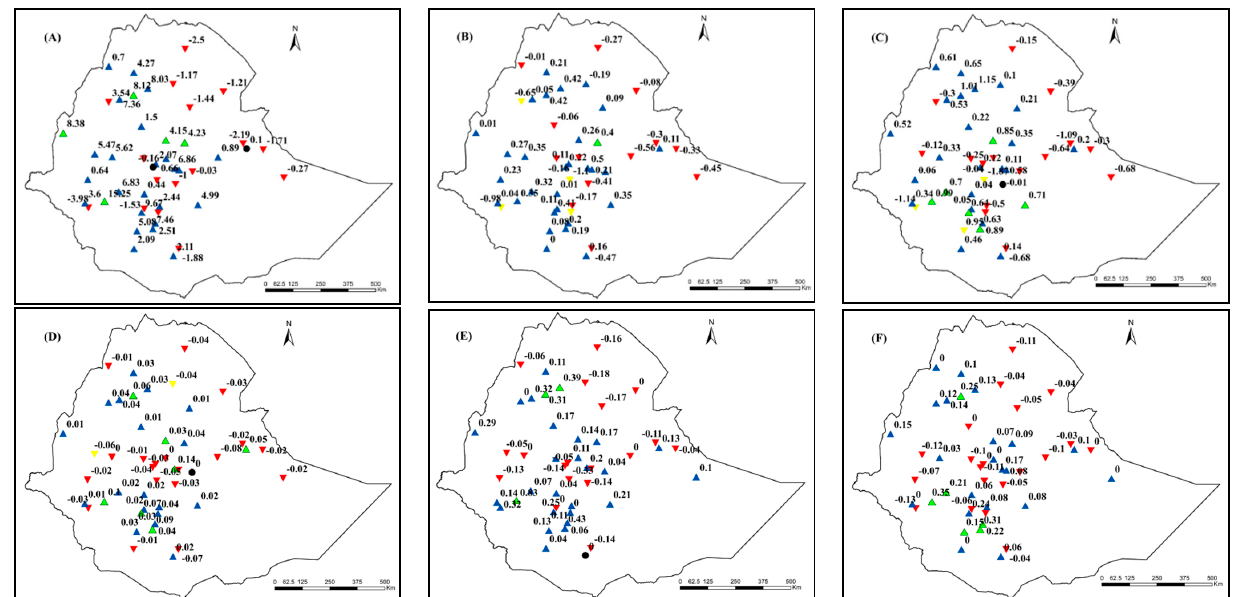
Figure 2. Spatial distributions of trends of the extreme rainfall indices over Ethiopia for the long- term period between 1986 and 2020: ( A ) PRCPTOT, ( B ) Rx1day, ( C ) Rx5day, ( D ) SDII, ( E ) R10, and ( F ) R20. Note: Filled blue upright and filled red inverted triangles indicate increasing and decreasing trends, respectively, while circles filled in black indicate no trend. Significantly increasing and decreasing trends are symbolized by filled green upright triangles and filled yellow inverted triangles, respectively. Insignificant trends are represented by filled upright and inverted triangles.